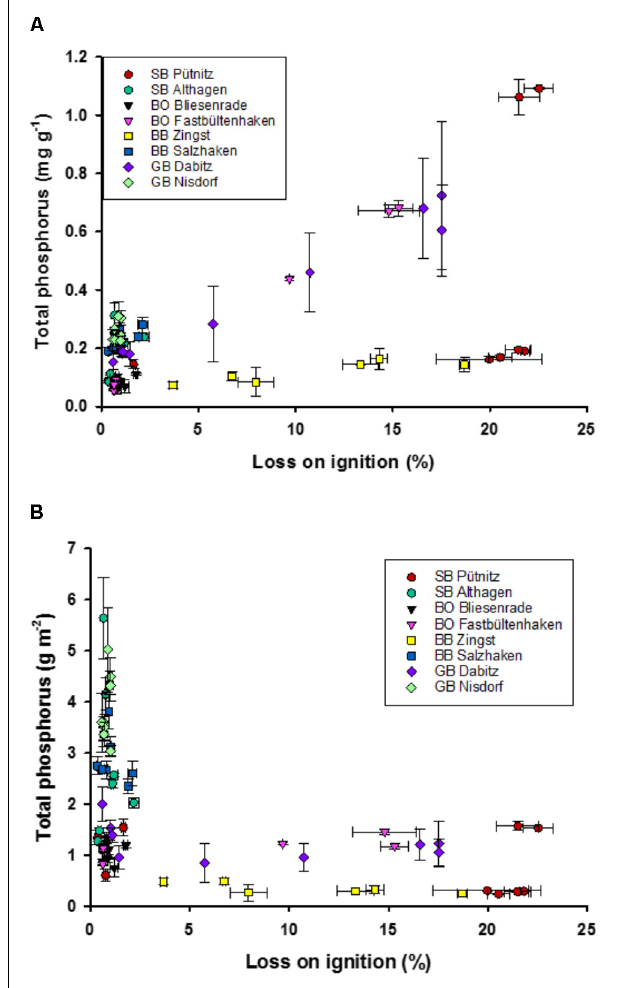
FIGURE 3 | Relationship of total phosphorus concentration (TP) in g P dry mass − 1 (A) and areal TP stock in g P m − 2 (B) to loss on ignition (%). Error bars are standard deviation of three replicate measurements for organic content and four for